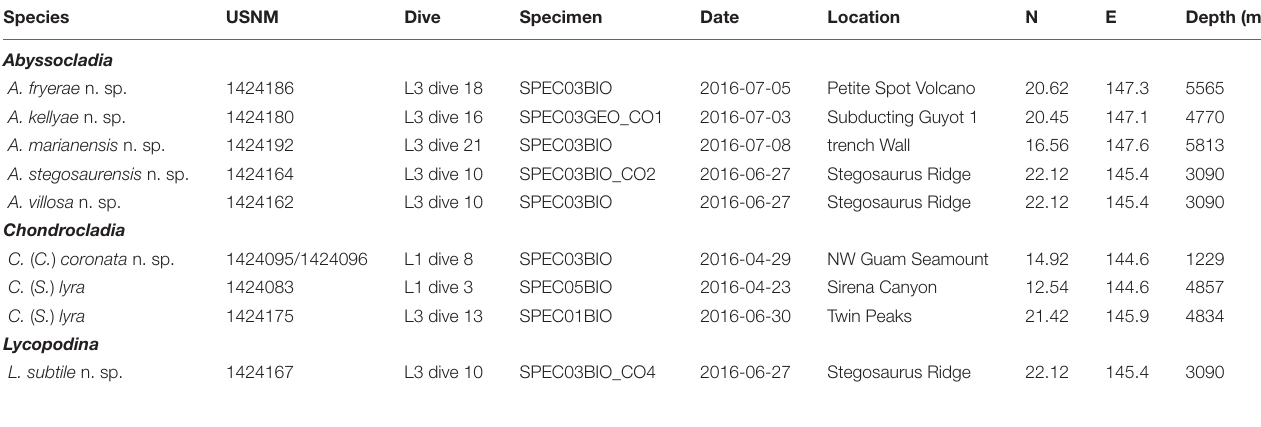
TABLE 1 | Collection and voucher information for carnivorous sponge specimens examined in this